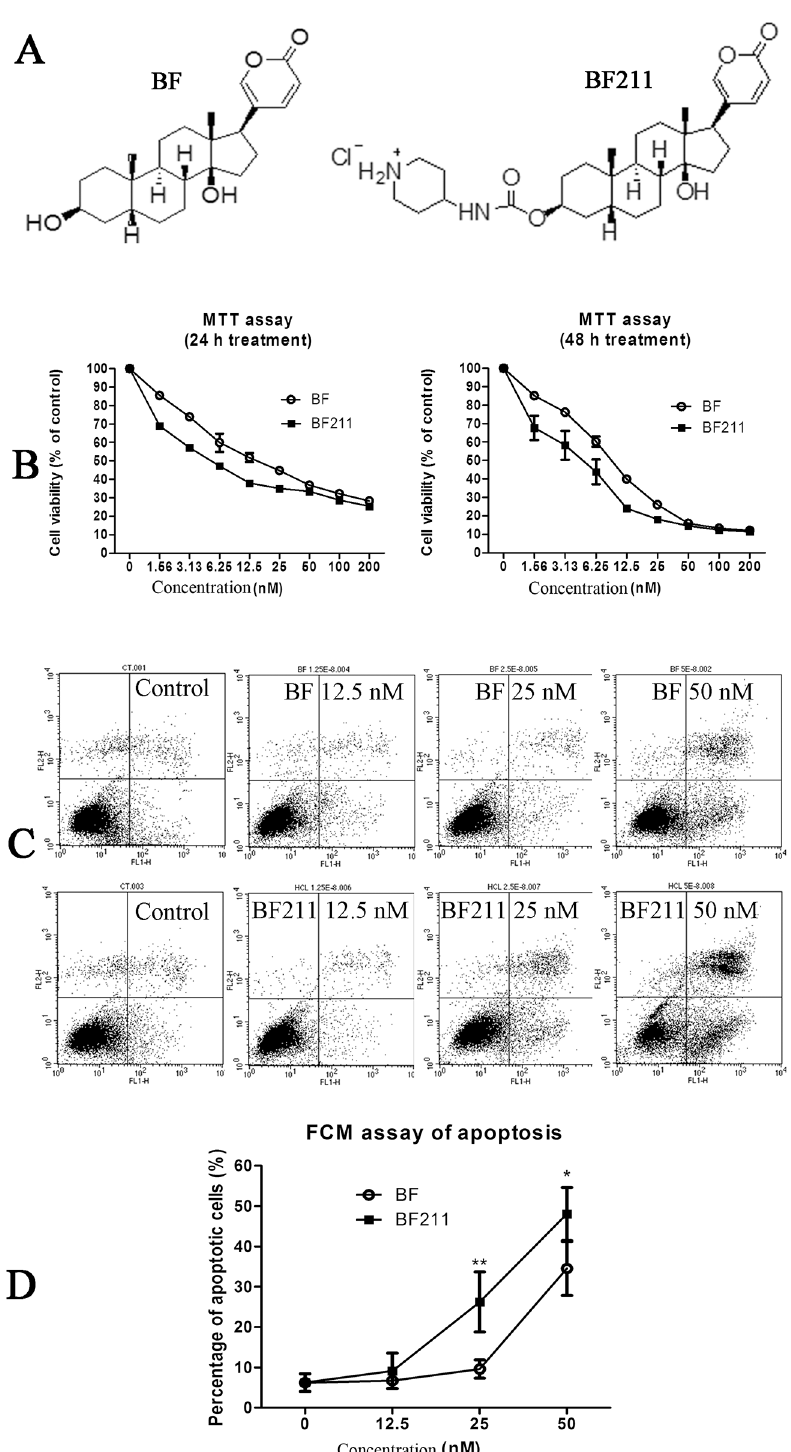
Fig 1. Inhibiting effects of BF and BF211 on the proliferation of A549 cells. (A) Chemical structures of BF and BF211. (B) The cell viability (MTT assay result) of A549 cells treated with various concentrations of BF or BF211 for 24 or 48 h. The data comprise the statistical results of three independent experiments. (B) A representative of the flow cytometry analysis results of apoptosis induced by 24 h treatment of BF or BF211 at different concentrations. (D) The statistical analysis results of the percentage of apoptotic cells